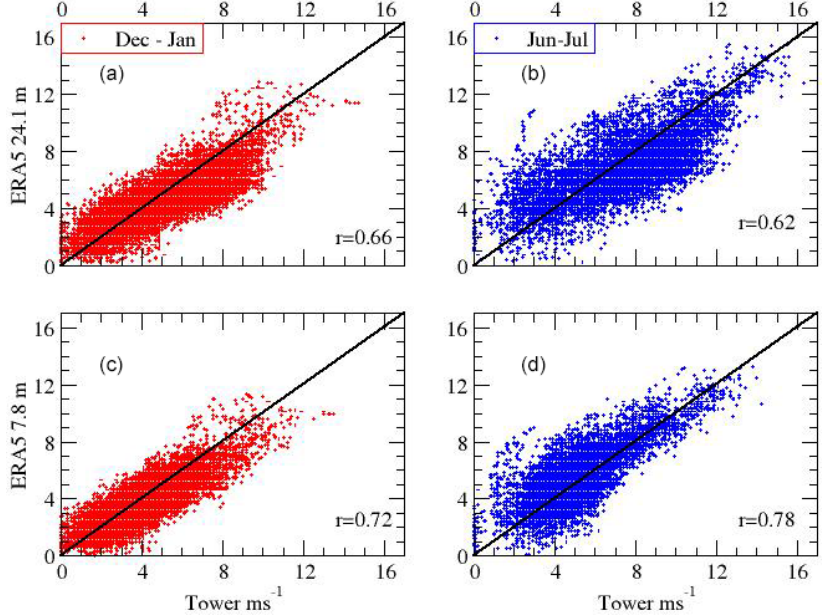
Figure 13. Scatter plots of ERA5 reanalysis wind speed versus observed tower wind speed (in ms − 1 ) at the two lowest ECMWF model levels above the surface, 7.8m (c, d) and 24.1m (a, b) , above surface for summer (a, c) and winter (b, d)